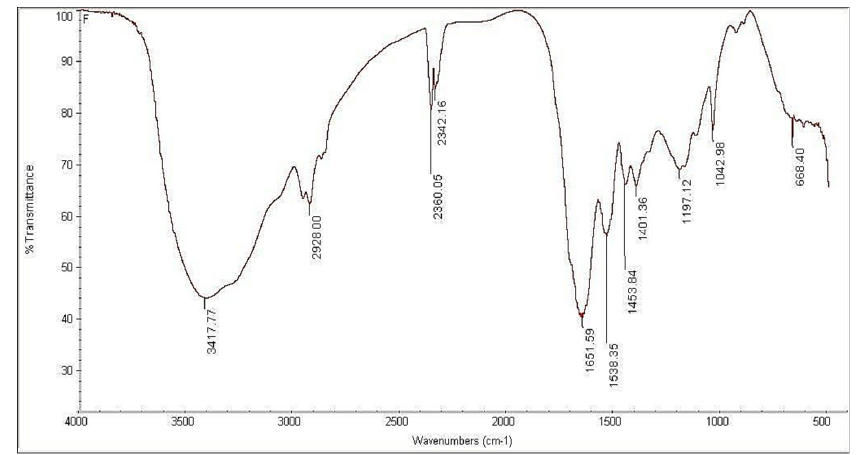
Figure 1. FT-IR Spectra of mantle of S.